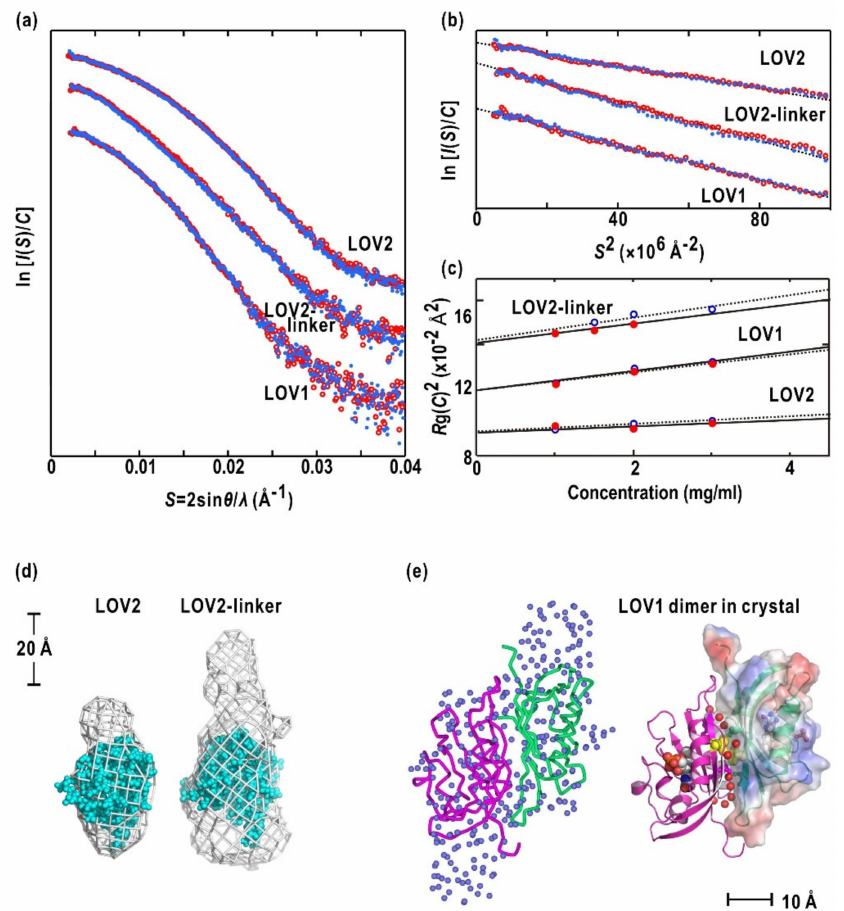
Figure 3. ( a ) SAXS profiles of LOV2 (top), LOV2-linker (middle), and LOV1 (bottom). The red circles and blue dots are profiles of D 450 and S 390 , respectively. The concentration of each specimen is 3 mg mL − 1 . ( b ) Guinier plots for LOV2, LOV2-linker and LOV1. ( c ) Concentration-dependent variation of R g(C) 2 values for LOV2-linker, LOV1, and LOV2 in the D 450 (red circles) and S 390 (blue) states. The linear concentration-dependences are indicated by black lines for D 450 and dashed lines for S 390 . ( d ) Molecular shapes of LOV2 and LOV2-linker averaged from ten restored models. The LOV2 model shown as space-filling model is fit to the main body of each molecular shape. ( e ) Superimposition of a restored SAXS model (an assembly of blue spheres) onto the crystal structure of LOV1 dimer [18]. The right panel shows a crystal structure of LOV1 dimer determined at a resolution of 2.0 Å (PDB accession code: 2Z6D) [18]. The models of the polypeptides are shown as ribbon models. FMN molecules are shown as a space-filling model in the left protomer, and as a stick model in the right protomer. Yellow-colored space-filling models and red spheres are Thr217 residues and hydration water molecules, both of which predominantly contribute to the dimer formation. The solvent-accessible surface of the right protomer is illustrated. Red- and blue-colored surfaces indicate the positions of negatively- and positively-charged sidechains of amino acid residues, respectively. Panels ( a ) and ( b ) are reused with modification from reference [41] with permission from American Chemical Society. The left panel in ( d ) is reused with modification from reference [18] with permission from